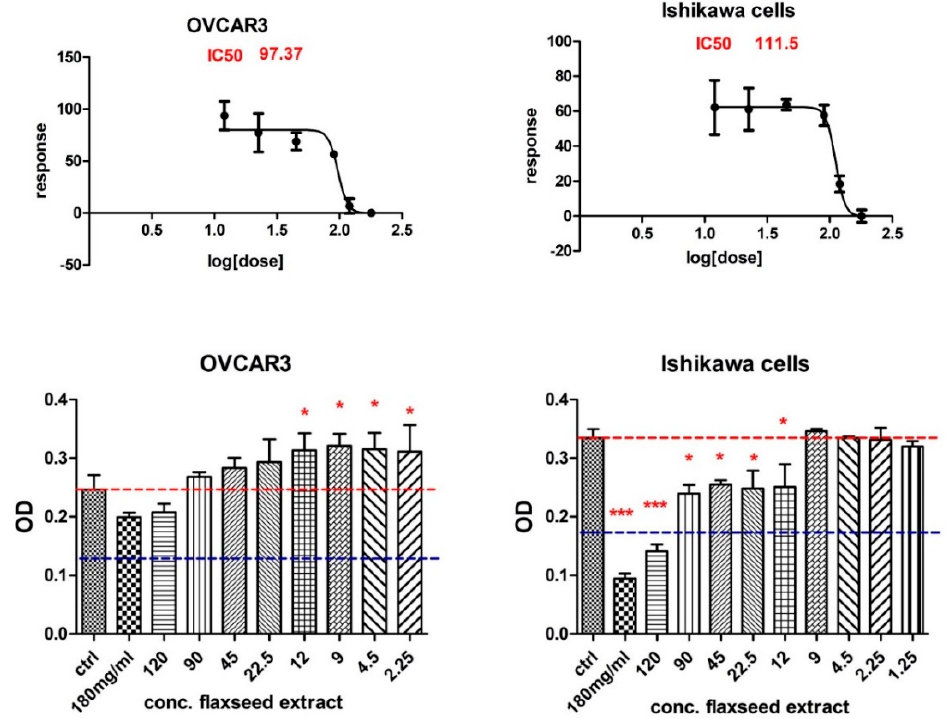
Figure 4. Comparison of the response of viability of ovarian adenocarcinoma cells (NIH:OVCAR-3) and endometrial adenocarcinoma cell line Ishikawa at different concentrations of flaxseed extract (MTT assay), where p ≤ 0.05 (*) and p ≤ 0.001 (***) as compared with control.